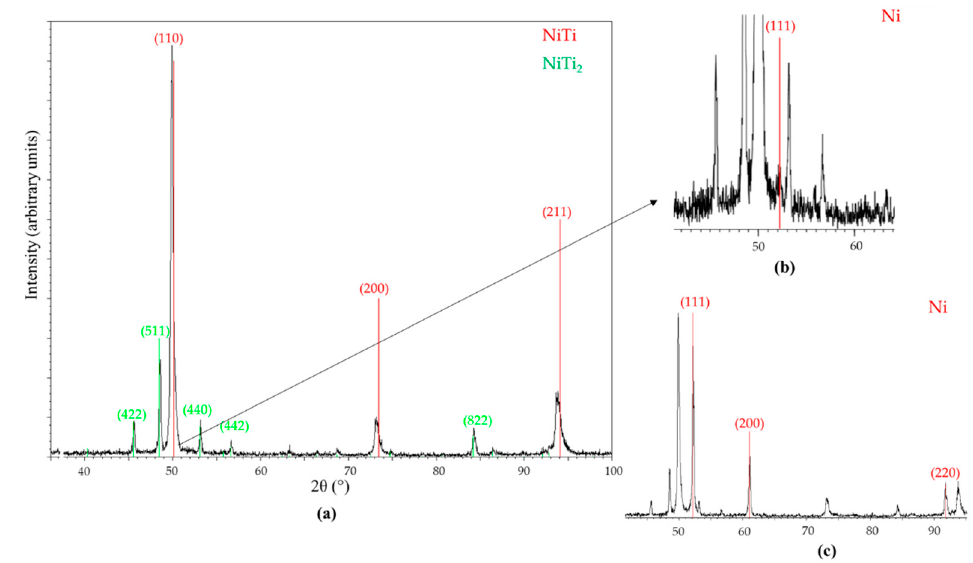
Figure 1. X-ray diffractogram of prealloyed NiTi powder containing ( a ) NiTi and NiTi 2 , ( b ) Ni, and ( c ) Ni after magnetic separation.